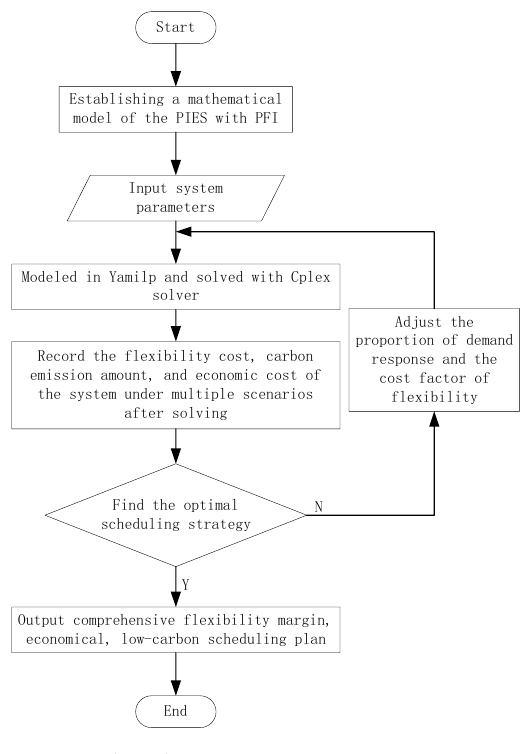
Figure 2. The solution process.